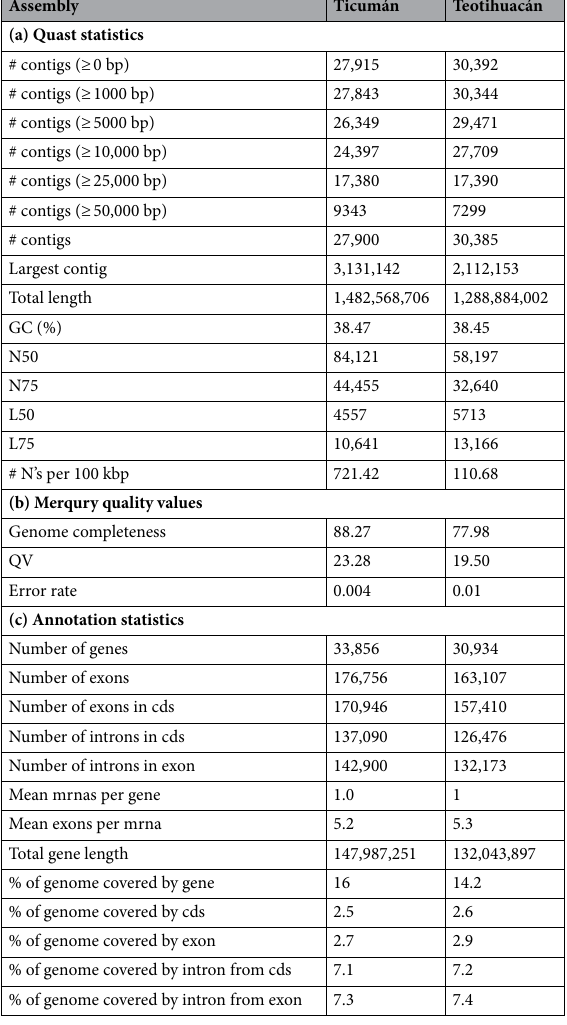
Table 1. (a) Assembly statistics for both genomes of Datura stramonium . (b) Merqury quality values (QV). (c) Annotation statistics for the Datura stramonium